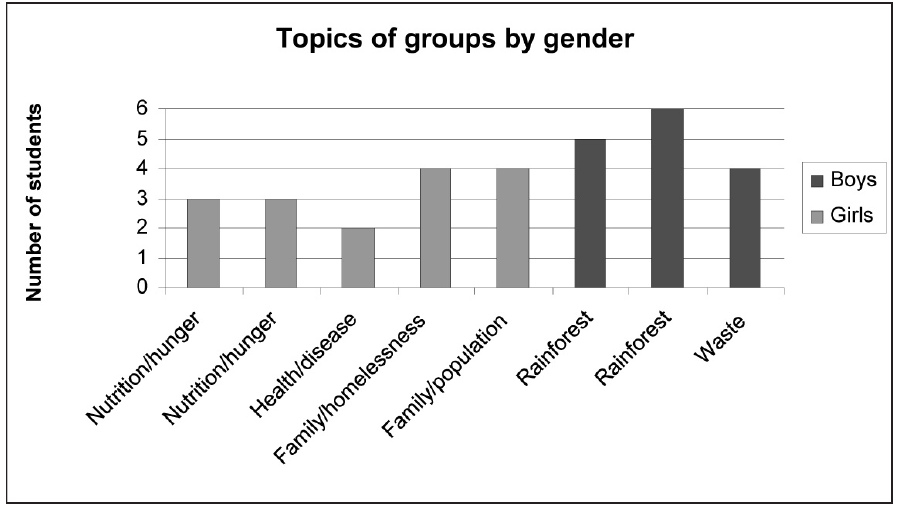
Figure 4: Topics of work